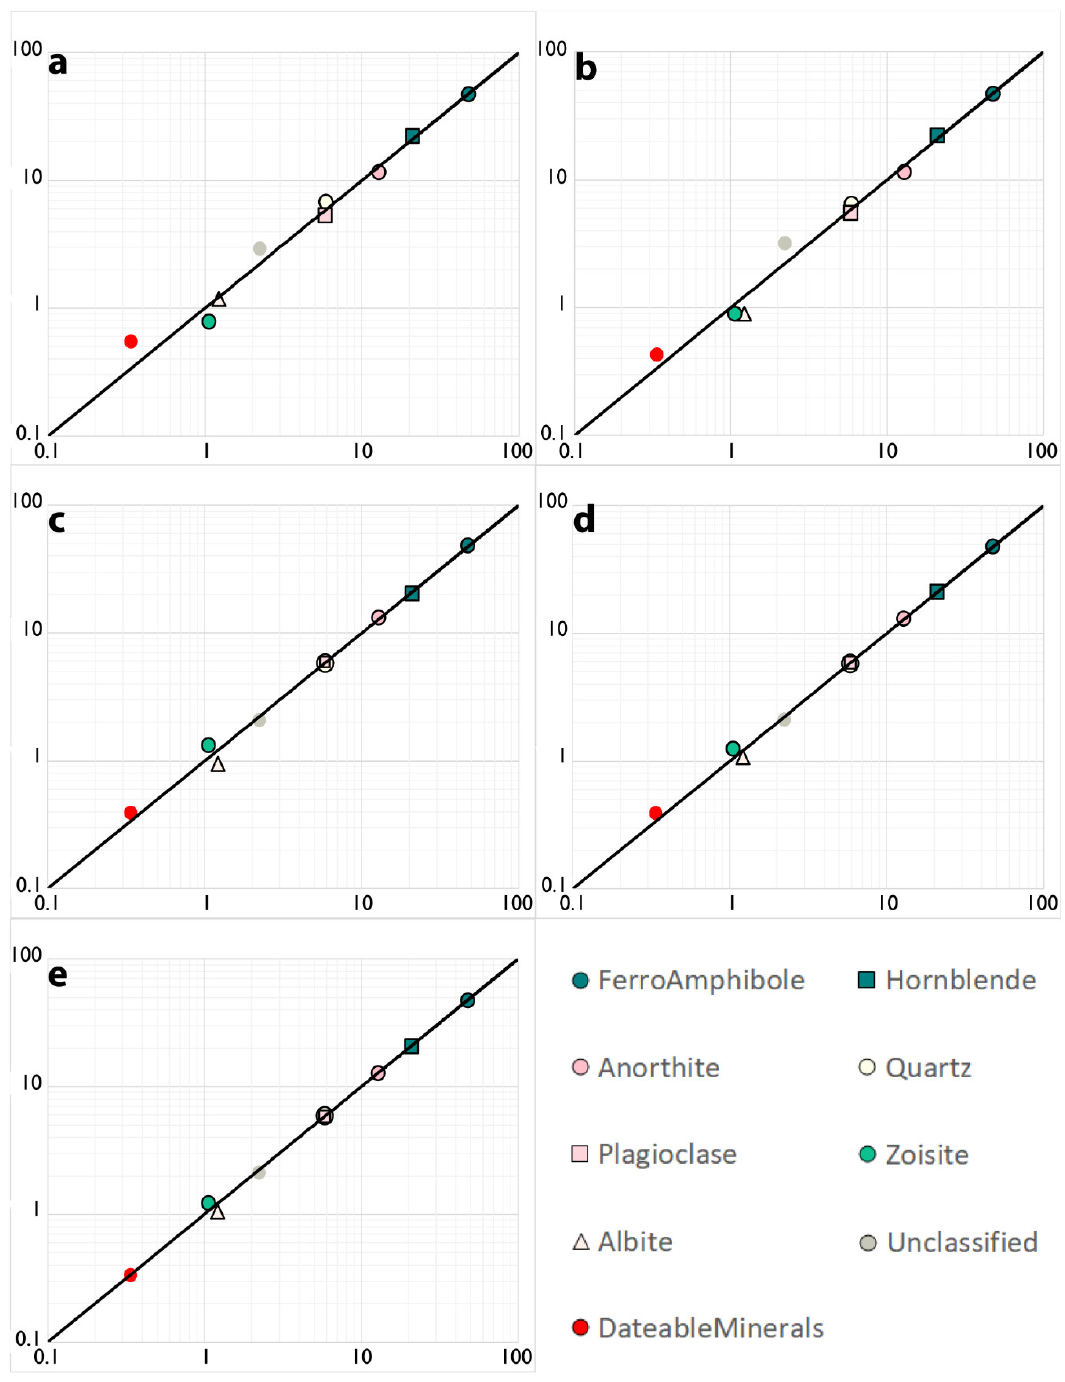
Figure 3. Logarithmic diagrams comparing the different analysis methods (y-axis) against the most time consuming and most detailed 5 µm step size mapping method (x-axis). Data is shown as area %. ( a ) 20 µm step size line-scan. ( b ) 10 µm step size line-scan. ( c ) 40 µm step size mapping. ( d ) 20 µm step size mapping. ( e ) 10 µm step size mapping. Dateable minerals are zircon, apatite, rutile and sphene.